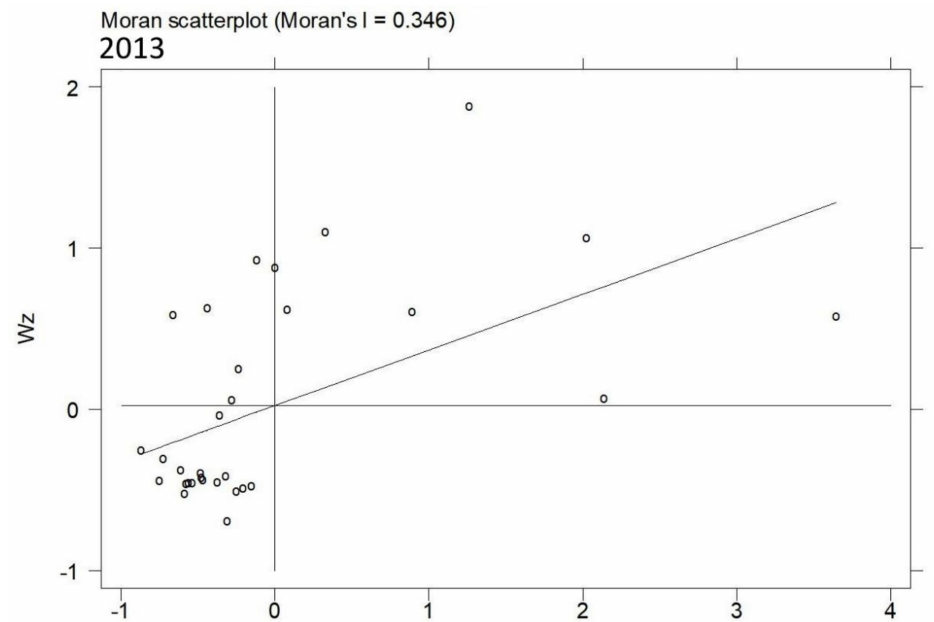
Figure 7. Moran scatterplot of the PCTLA s in the 31 Chinese provinces in 2013.